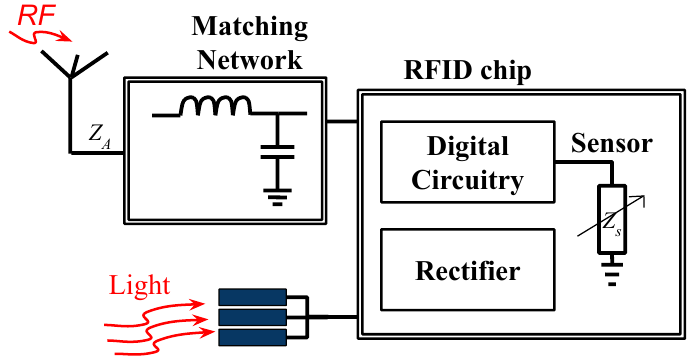
Figure 13. Block diagram of a chip-based ambient (light) energy-harvesting wireless